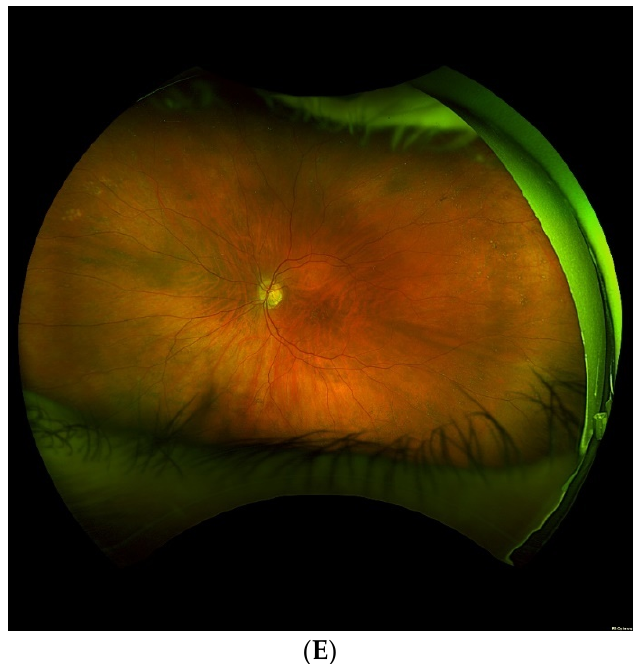
Figure 1. Exemplary ultra-widefield images of eyes with macular degeneration and peripheral abnormalities. Pseudocolor and corresponding autofluorescence of a left eye demonstrating multifocal retinal pigment epithelium (RPE) atrophy and drusen in the macula with peripheral drusen and multifocal RPE atrophy, especially nasal to the optic nerve. Note there is a glaucomatous disk hemorrhage and a peripheral retinal tear status post laser retinopexy ( A , B ). Another example demonstrates a right eye with macular drusen and peripheral drusen and multifocal atrophy in the far periphery ( C , D ). A left eye with macular drusen and pigment changes and drusenoid bodies and mild reticular pseudopigmentation in the periphery. Note eyelash artifact inferior ( E ).